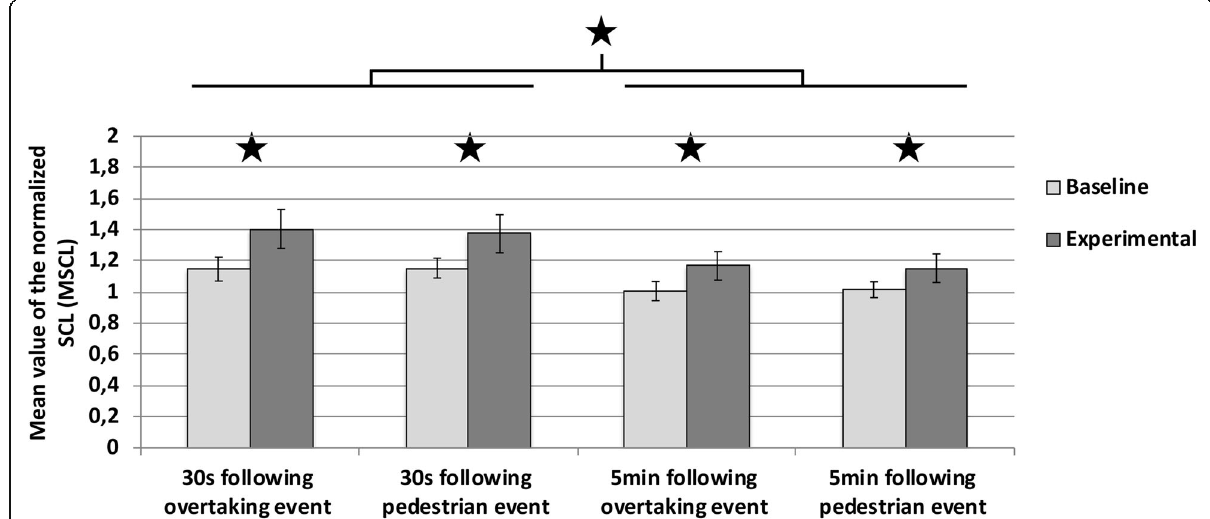
Fig. 2 Mean value of the normalized SCL (noted MSCL) obtained after the events as a function of the temporal window and the condition. The vertical bars indicate the standard error and the asterisks indicate a significant